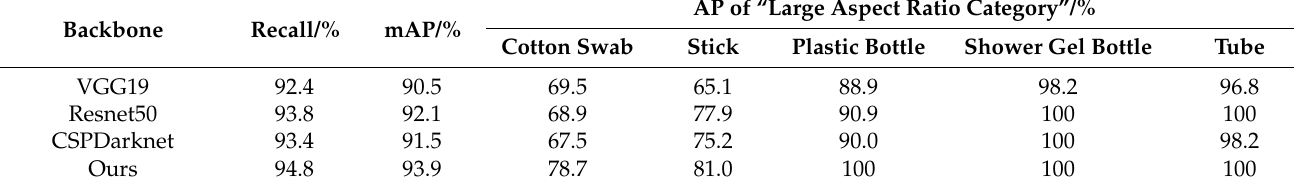
Table 5. Effect comparison with different backbones.